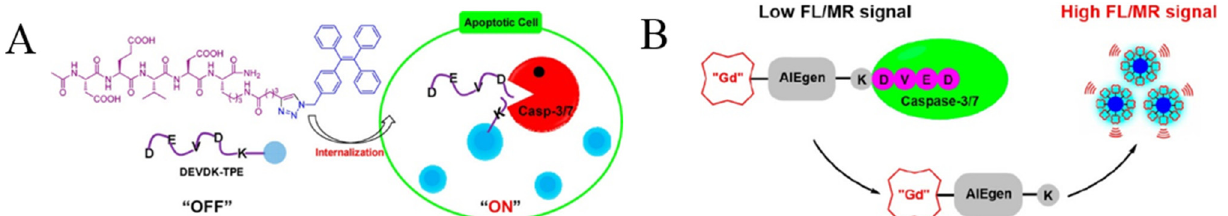
Figure 3. ( A ) Illustration of Ac-DEVDK-TPE for the study of caspase activities. Reprinted with permission from ref. [46]. Copyright 2012, American Chemical Society. ( B ) Schematic illustration of DPBP as a bioprobe for autophagy detection. Reprinted with permission from ref. [49]. Copyright 2019, American Chemical Society.